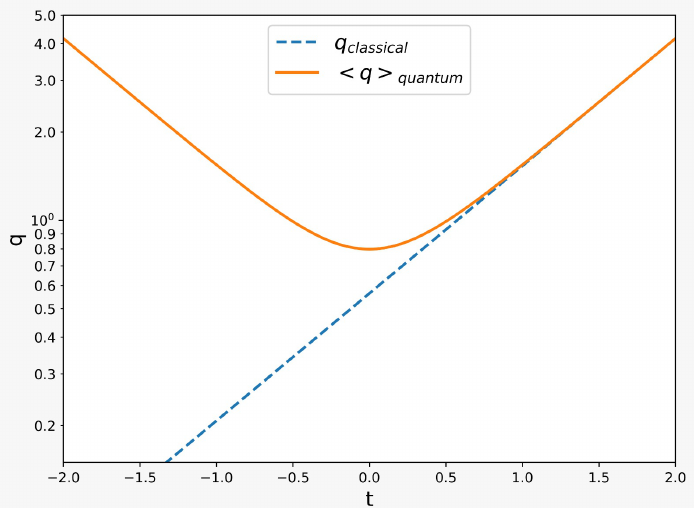
Figure 1. Time evolution of the expectation value of the scale variable q for φ = π /4. We set ω =